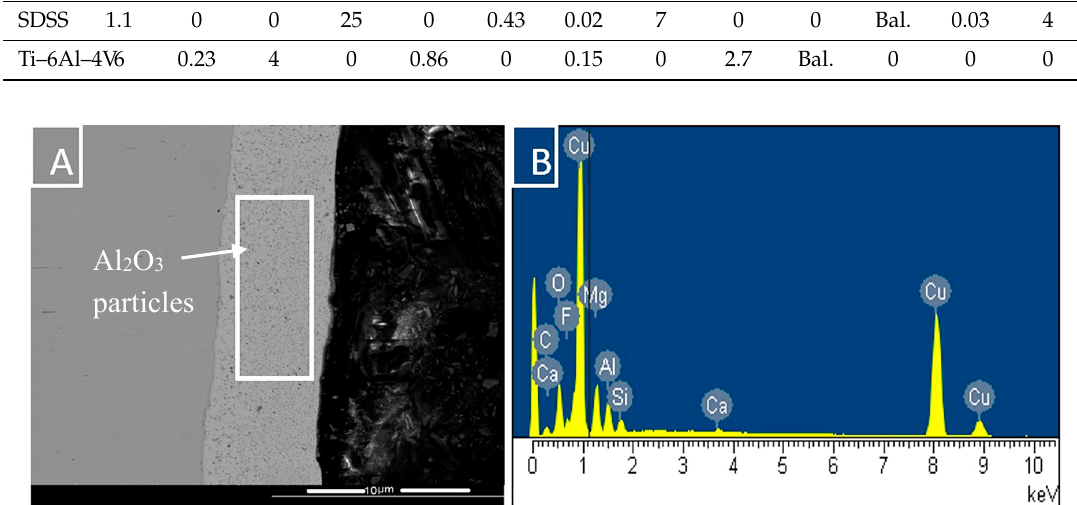
Figure 1. ( A ) Cu/Al 2 O 3 coating deposited on the titanium; ( B ) EDS spectrum of the highlighted region confirming the elements present in the Cu/Al 2 O 3 coating.